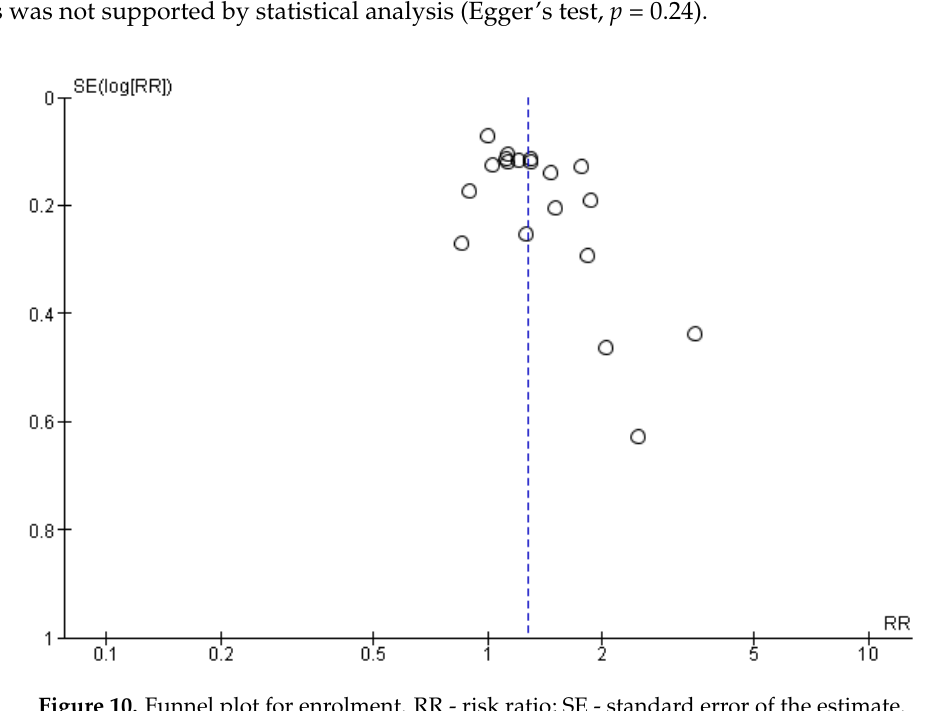
Figure 10. Funnel plot for enrolment. RR - risk ratio; SE - standard error of the estimate.